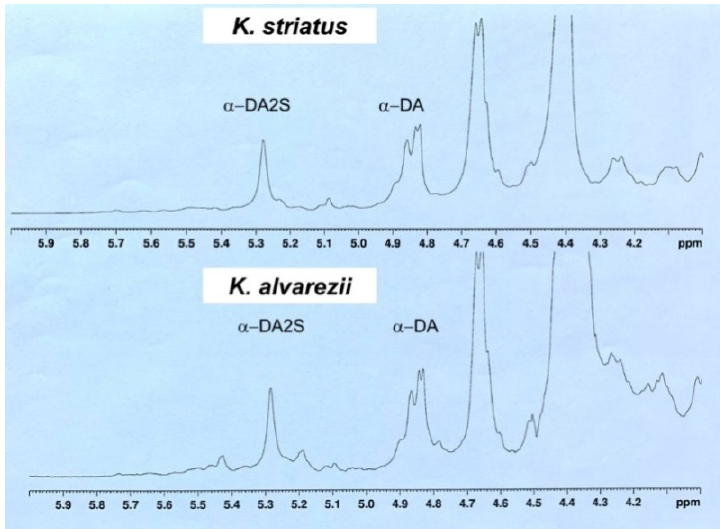
Figure 3. Anomeric region of the 1 H-NMR spectra of the carrageenans from K. alvarezii and K. striatus. In the 1 H-NMR spectra, the α -anomeric signals α -DA and α -DA2S units were inte- grated, and taking 1 as a reference value, the integral of the signal of TSP standard and their values were compared. In particular, if, in the K. alvarezii fraction, the anomeric protons ratio between α -DA (4.89 ppm; 13 C 97.80 ppm) and α -DA2S (5.28 ppm; 13 C 94.905 ppm) integrals was 1.46, in the case of the K. striatus fraction, the anomeric protons ratio between α -DA (4.84 ppm; 13 C 97.87 ppm) and α -DA2S (5.27 ppm; 13 C 94.901 ppm) integrals would be 2.15. In this last case, although κ -carrageenan polysaccharide was most abundant, a significant signal at 5.42 ppm in the 1 H-NMR spectra also suggested the presence of -and λ